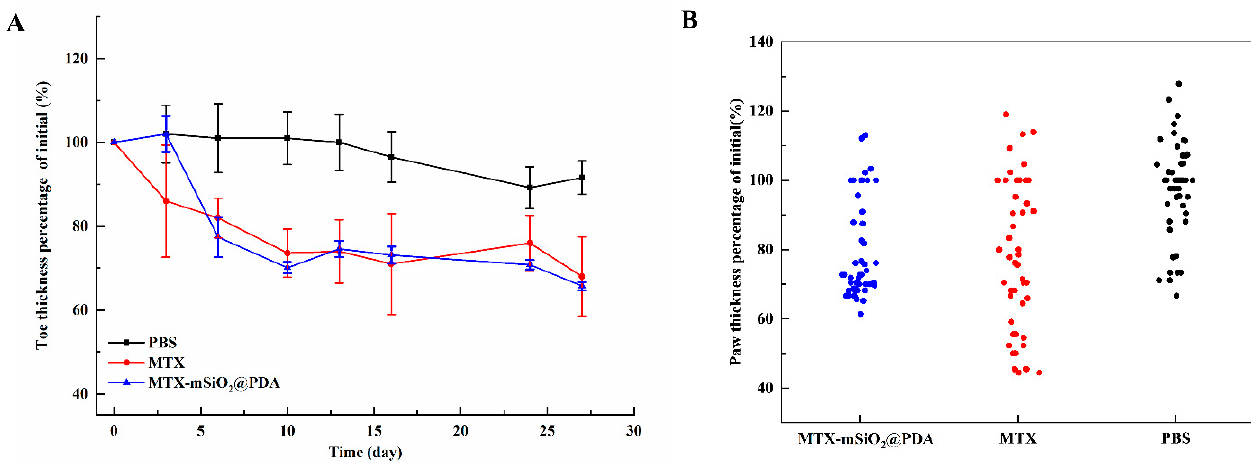
Figure 8. Effect of different modes of MTX administration on the degree of paw swelling ( A ) The variation of toe thickness percentage of initial during 27 days ( B ) The distribution of toe thickness percentage of initial in each group. Data are shown as mean ± SEM (n = 6).